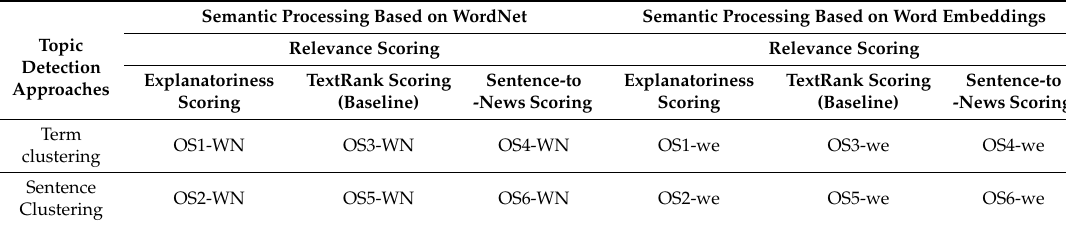
Table 2. Characterization and identification of the evaluated